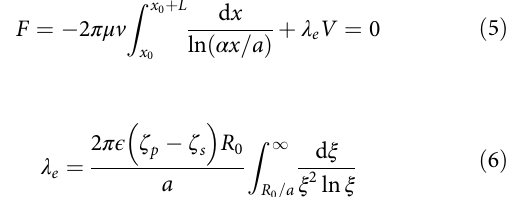
of Fig. 5 to the voltage (600mV) used for translocations. The extrapolation also corrected for a small offset at 0mV in Fig.